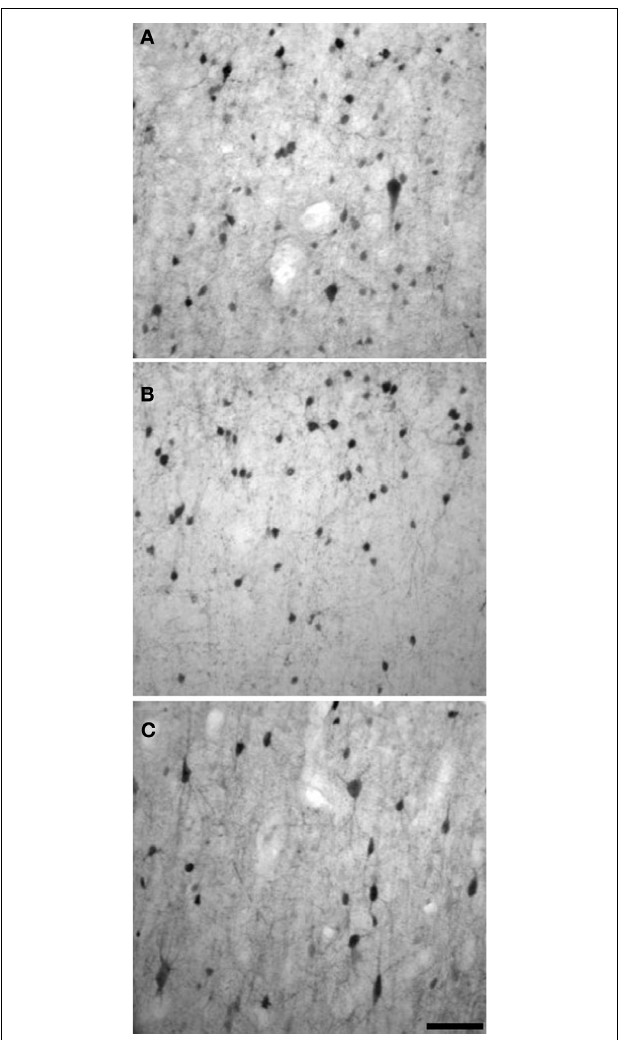
FIGURE 3 | Examples of CB (A), CR (B), and PV (C) immunostaining in layers II/III of chimpanzee motor cortex. Scale bar = 50 µm.